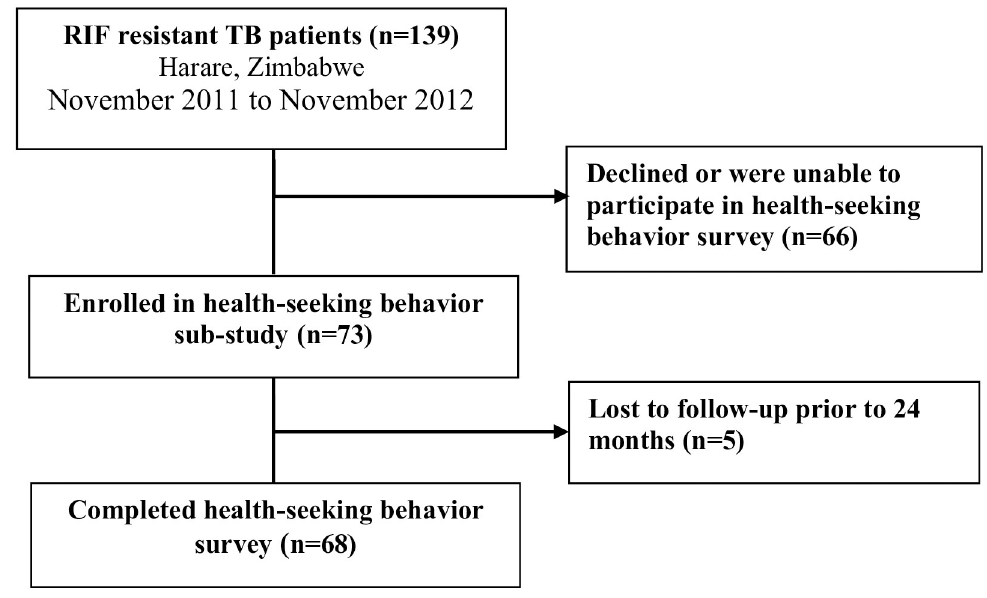
Fig 1. Participant flowchart (n =